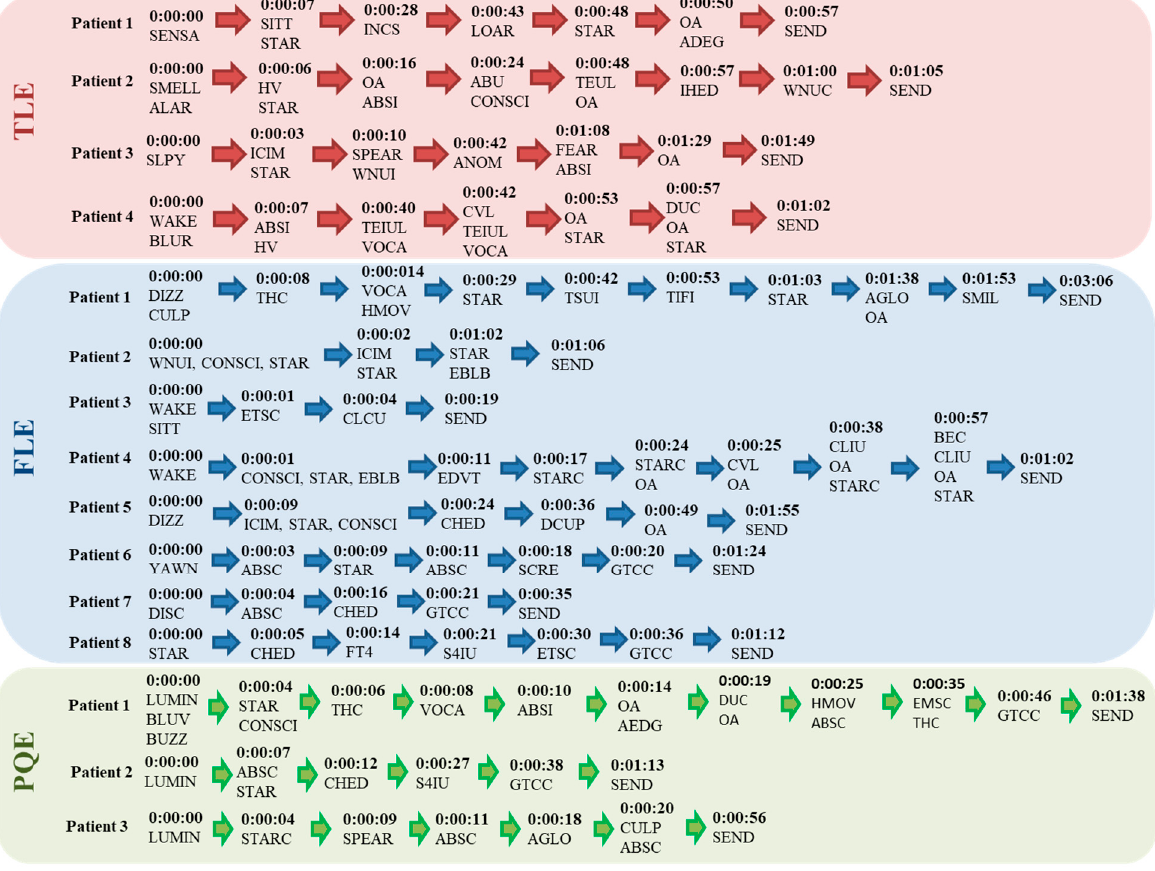
Figure 2. Temporal sequences of ictal behavioral patterns in patients with TLE and Ex E. TLE (temporal lobe epilepsy), FLE (frontal lobe epilepsy), PQE (posterior quadrant epilepsy), SENSA (strange sensation throughout the body), SMELL (strange smell), SLPY (sleepy), BLUR (blurred mind), SITT (sitting down), STAR (staring), INCS (incoherent speech), LOAR (looking around), OA (oral automatisms), ADEG (automatism, deglutition), ALAR (alarm), HV (hyperventilation), ABSI (automatisms, ipsilateral upper limb), ABU (automatism, bimanual), CONSCI (impaired consciousness), TEUL (tonic extension, upper limbs), IHED (ipsilateral head and eye deviation), WNUC (automatism, contralateral wiping/touching the nose), ICIM (ictal immobility), SPEAR (speech arrest), WNUI (automatism, ipsilateral wiping/touching the nose), ANOM (nominal afasia), FEAR (fear), WAKE (awakening), TEIUL (tonic extension, ipsilateral upper limb), VOCA (vocalization), CVL (cephalic version to the left), DUC (dystonia, contralateral hand), DIZZ (dizziness), LIGHT (see a light), LUMIN (luminous sparkles), BLUV (blurred vision), BUZZ (ear buzzing), THC (tonic contraction of the contralateral half face), HMOV (hyperkinesis), TSUI (tremor, ipsilateral upper limb), TIFI (tremor, ipsilateral lower limb), SMIL (smiling), ABSC (automatisms, contralateral upper limb), EMSC (elevation of the contralateral upper limb), CHED (contralateral head and eye deviation), S4IU (sign of “4” with ipsilateral arm extension), EBLB (bilateral eye blinking), GTCC (bilateral tonic-clonic), AGLO (automatism, global), STARC (contralateral staring), CULP (contralateral upper limb paresthesia), CLCU (clonus, contralateral upper limb), EDVT (eye deviation to the top), CLIU (clonus, ipsilateral upper limb), BEC (bilateral eyelid clonus), DCUP (dystonia, contralateral upper limb), YAWN (yawn), SCRE (screaming), DISC (disconnection), TF4 (tonic flexion 4 limbs), SEND (end of seizure).